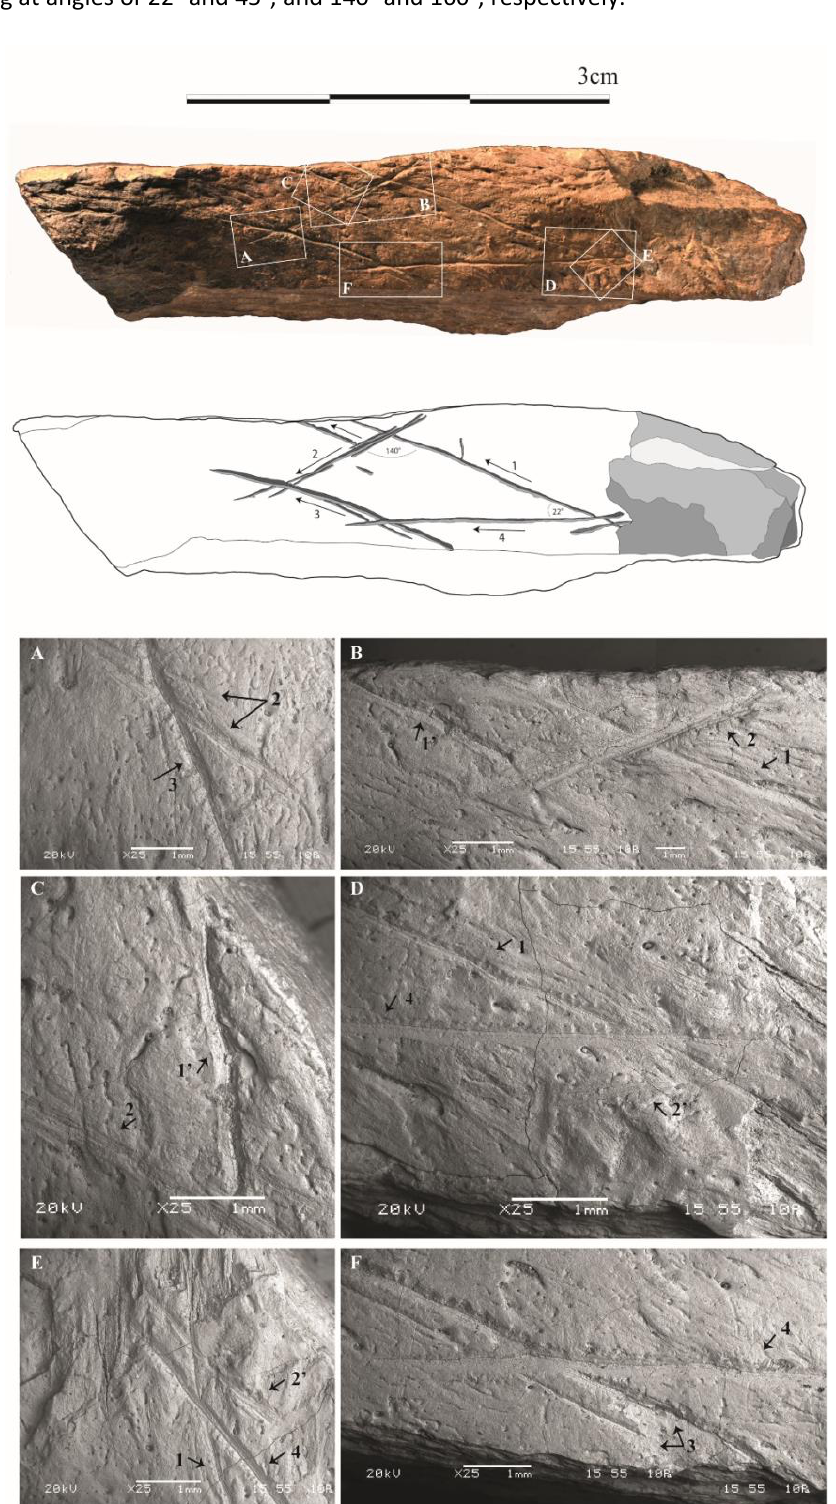
rhomboid pattern comprises two parallel lines (incisions 1 and 3) and two converging lines (incisions 2 and 4), intersecting at angles of 22° and 45°, and 140° and 160°, respectively.